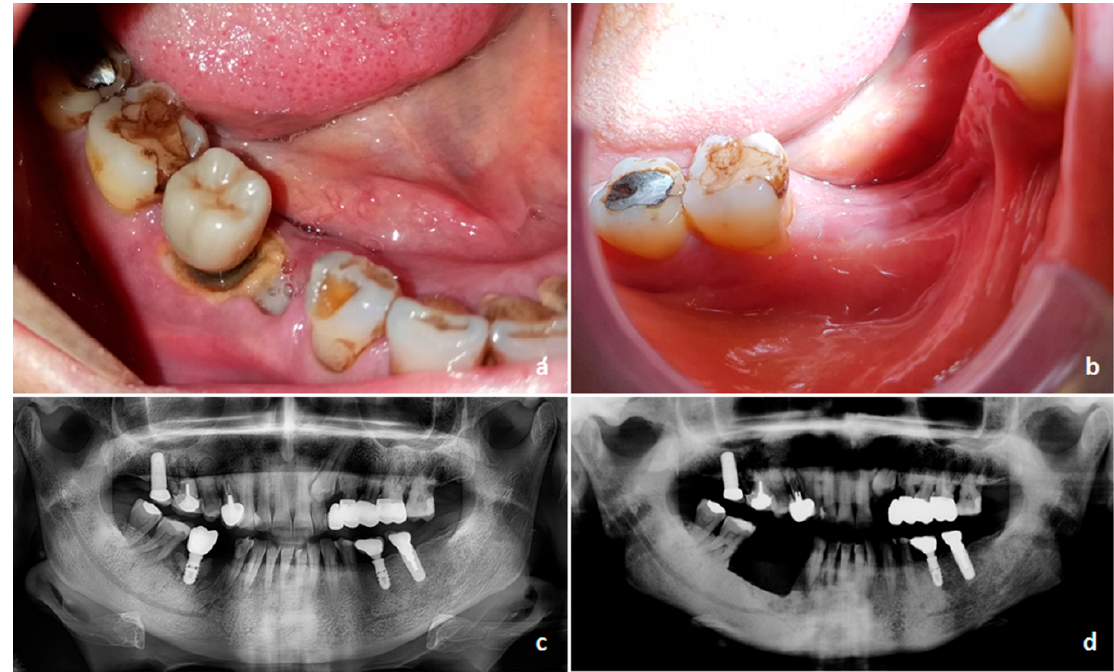
Figure 3. Clinical aspect of classical exposed bone variant of osteonecrosis of the jaw (ONJ). ( a ) Intraoral view of exposed and necrotic bone around a dental endosseous implant, together with infected post-extraction socket of dental element 45, with purulent discharge. Due to multiple myeloma, the patient had received zoledronate one year before. Extraction of tooth 45 was the trigger factor for ONJ. ( b ) Preoperative panoramic radiograph showing absent bone remodelling of the 45-extraction socket. ( c ) Postoperative healed intraoral view after a marginal mandibulectomy for removing the diseased bone. Primary closure of the surgical site was obtained by mobilization of a muco-periosteal flap. ( d ) Postoperative panoramic radiograph showing changes to trabecular pattern-dense bone of right hemi-mandibular body.